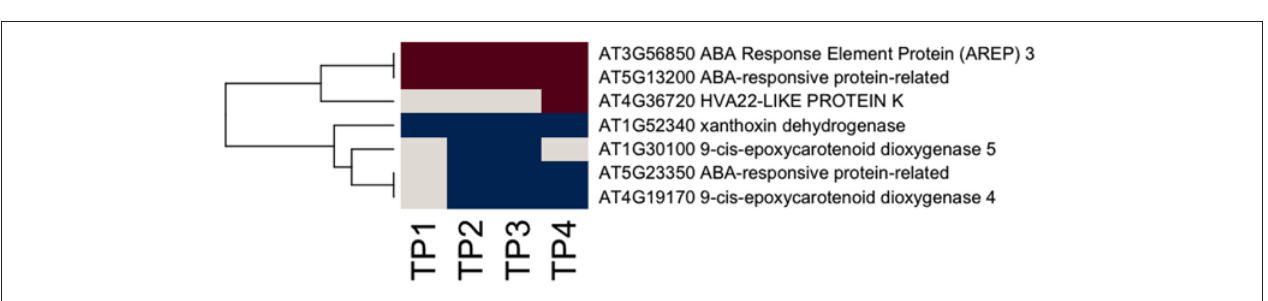
FIGURE 6 | ABA-related gene expression across the time course of winter hardening. The gene expression levels across the rows are hierarchically clustered. Magenta cells represent significant positive